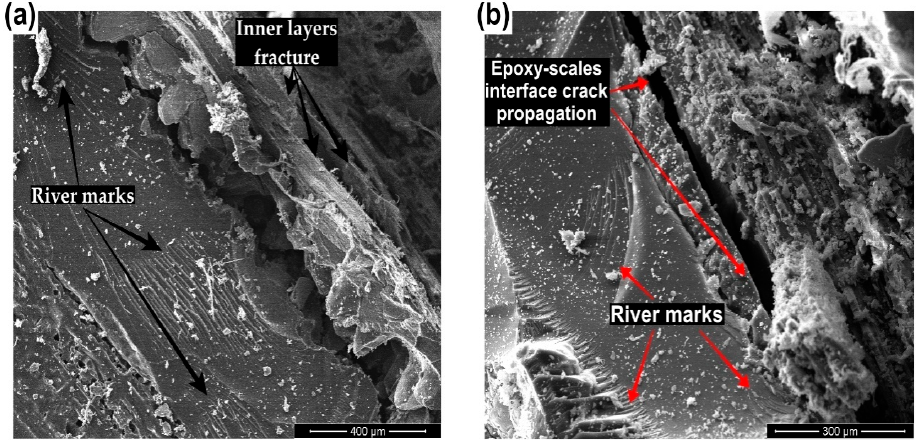
Figure 13. SEM images presenting different mechanisms of energy absorption shown by the com- posites: ( a ) “river marks” and the arapaima scales mechanisms, such as inner layers fracture; and ( b ) interfacial separation.